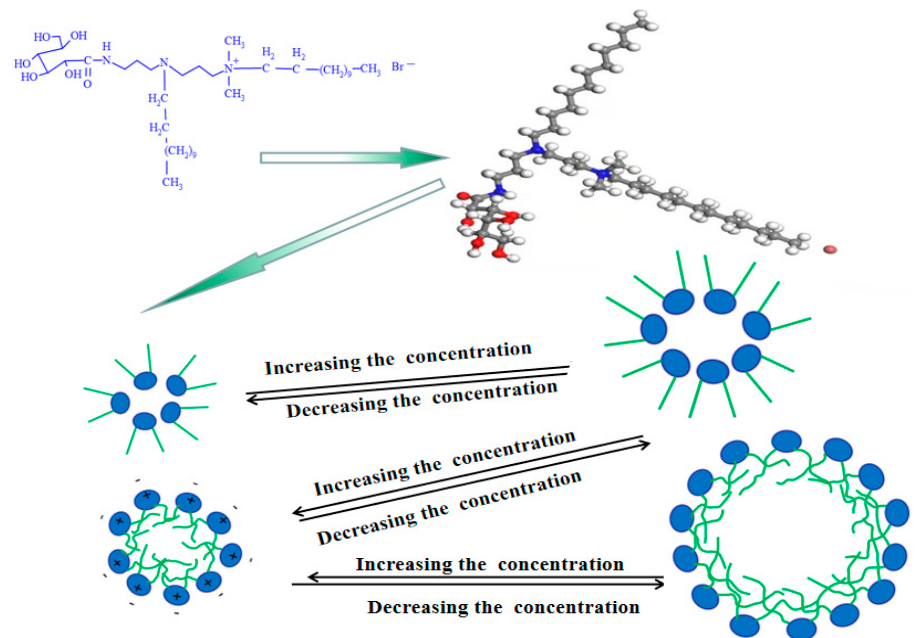
Figure 11. Micellar transition model for the C n DDGPB surfactants.